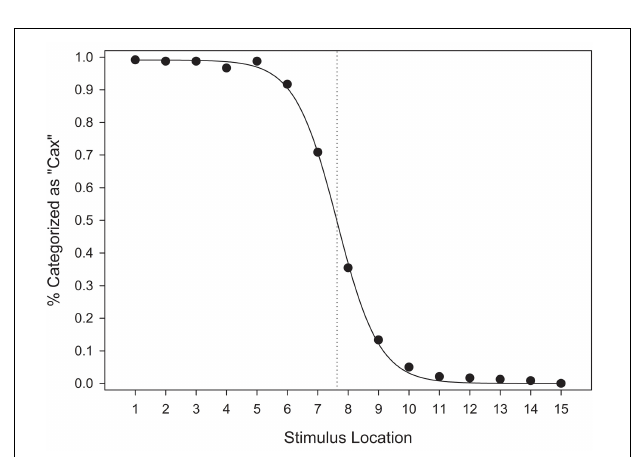
FIGURE 14 | Categorization response frequencies in the unequal frequency, unequal distribution condition. Stimulus values correspond to stimuli selected from the entire stimulus range (i.e., stimuli 1–15). The vertical dashed line represent the estimated category